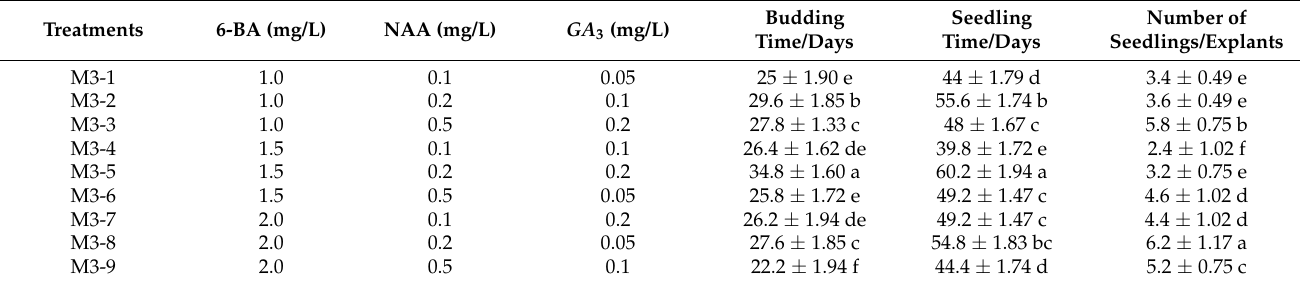
Table 5. PGR combinations for one-step seedling and regeneration time.